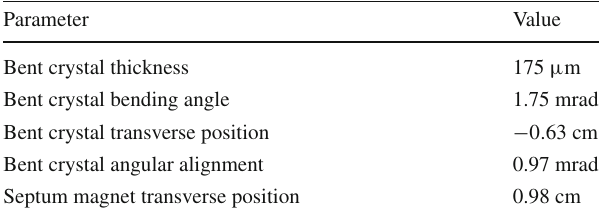
7 Preliminary experimental setup